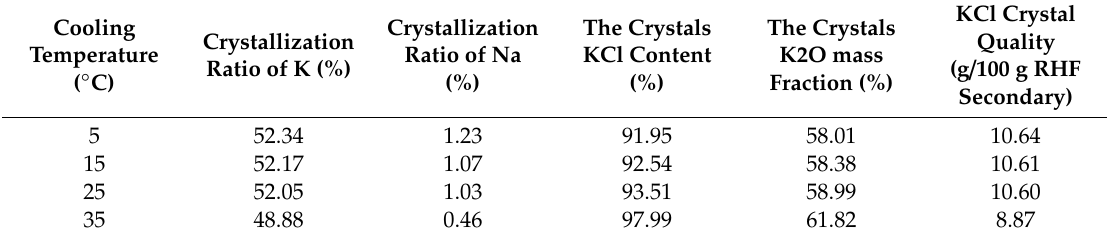
Table 9. Experimental results at di ff erent cooling